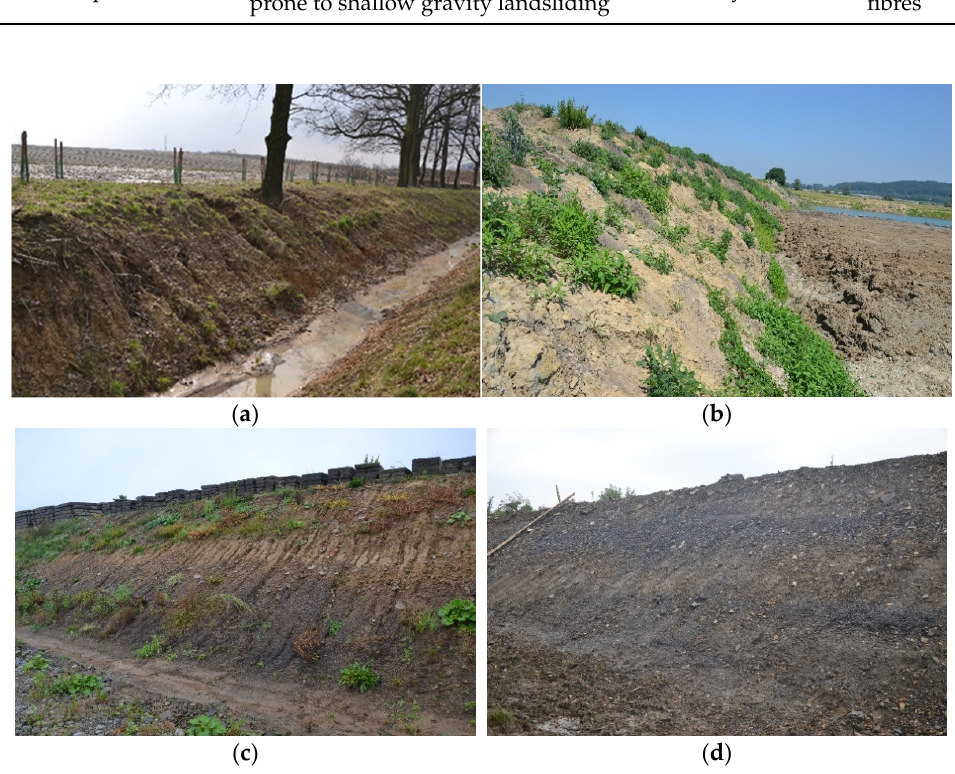
Figure 2. The protected objects before the installation of the ropes. ( a ) Miedzyrzecze; ( b ) Nieboczowy; ( c ) Lipnik; ( d ) Wapienica. Table 1. The objects that were protected using ropes.